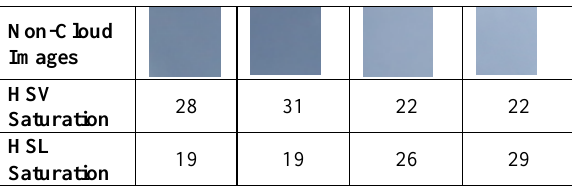
Table 2. Saturation values for non-cloud image regions